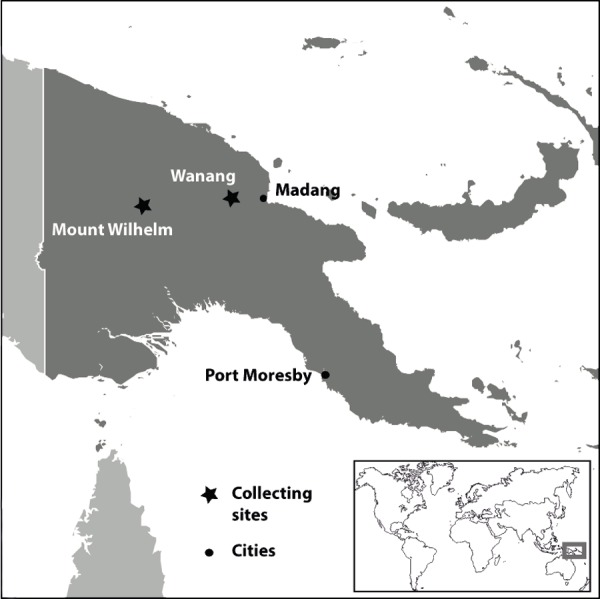
Location of collecting sites in Papua New Guinea.